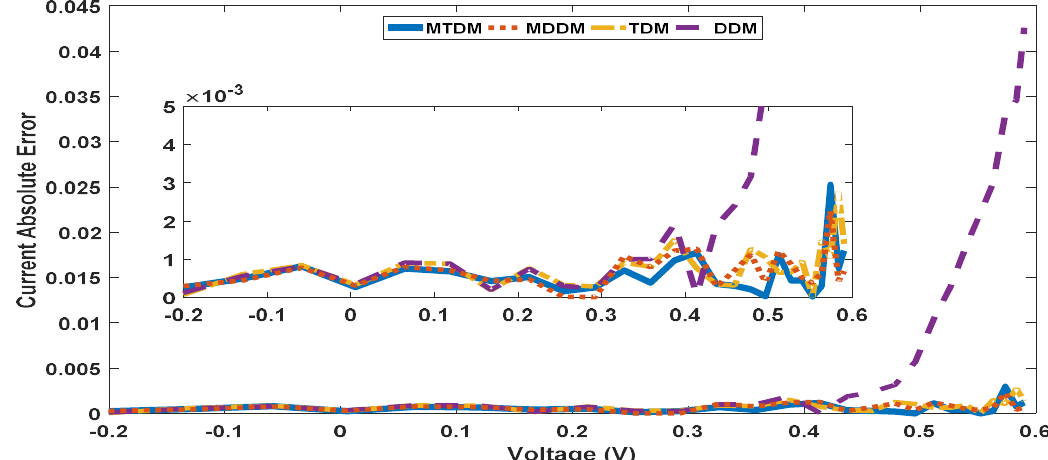
Figure 12. Current absolute error calculated for all models.